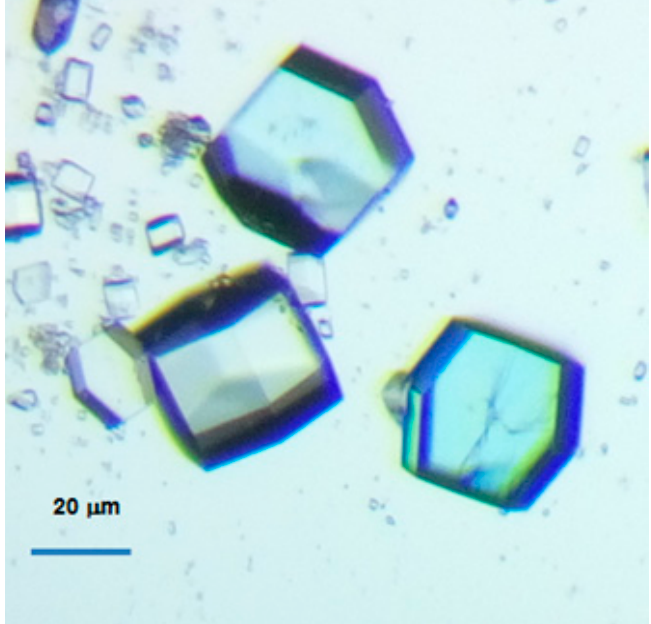
Figure 2. Micrograph of the protein crystals used in the study. The crystallization procedure yielded lysozyme crystals of the tetragonal space group P4 3 2 1 2 (Table 1). The scale bar corresponds to 20 μ m.